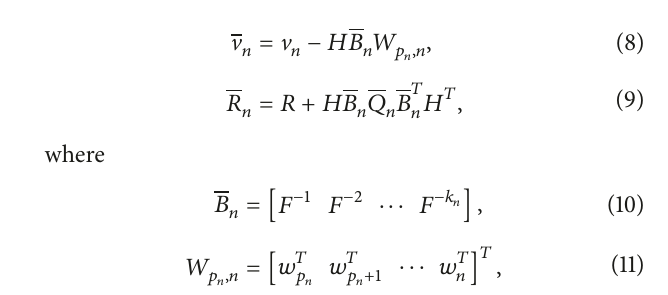
and the covariance 𝑅 𝑛 = 𝐸{ V 𝑛 V